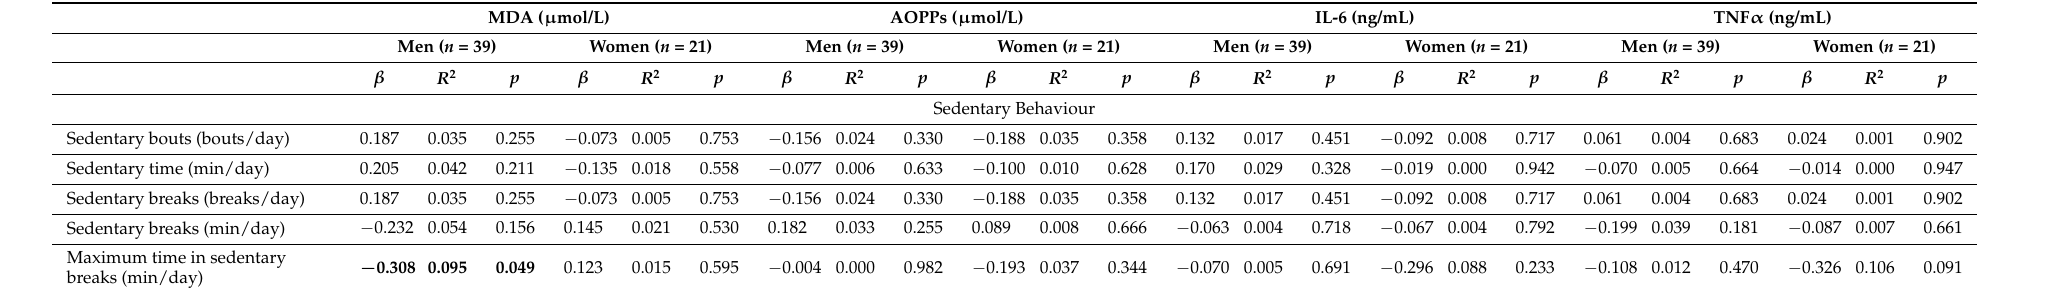
Table 3. Associations of physical activity and sedentary behaviour with plasma markers of oxidative stress and